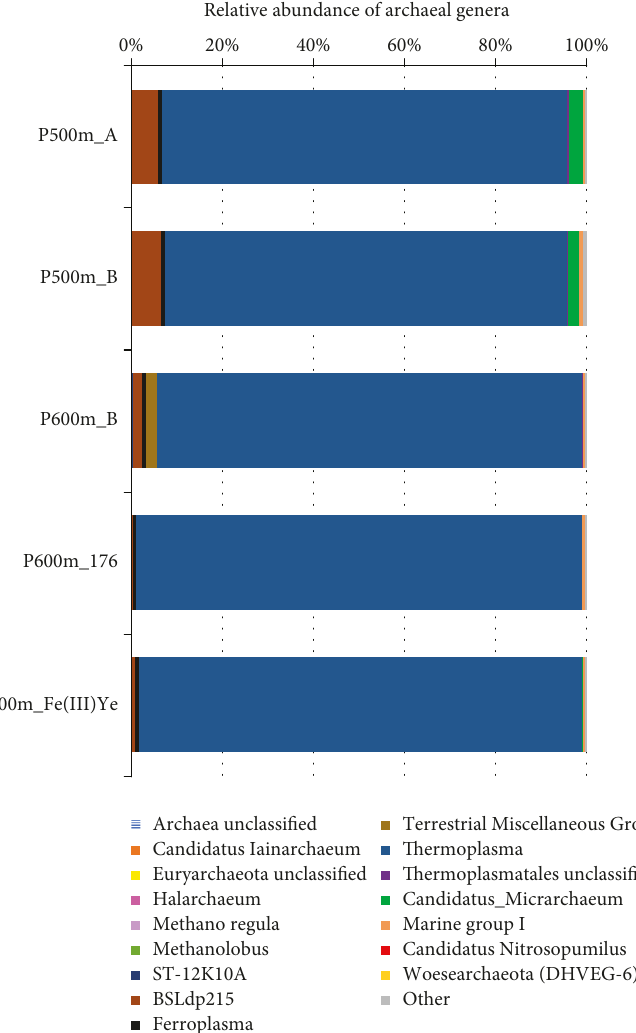
Figure 7: The relative abundance of archaeal 16S rRNA gene sequence reads in the samples and enrichment cultures from 500 m and 600 m belowground. No archaeal sequence reads were detected from the other samples or enrichment